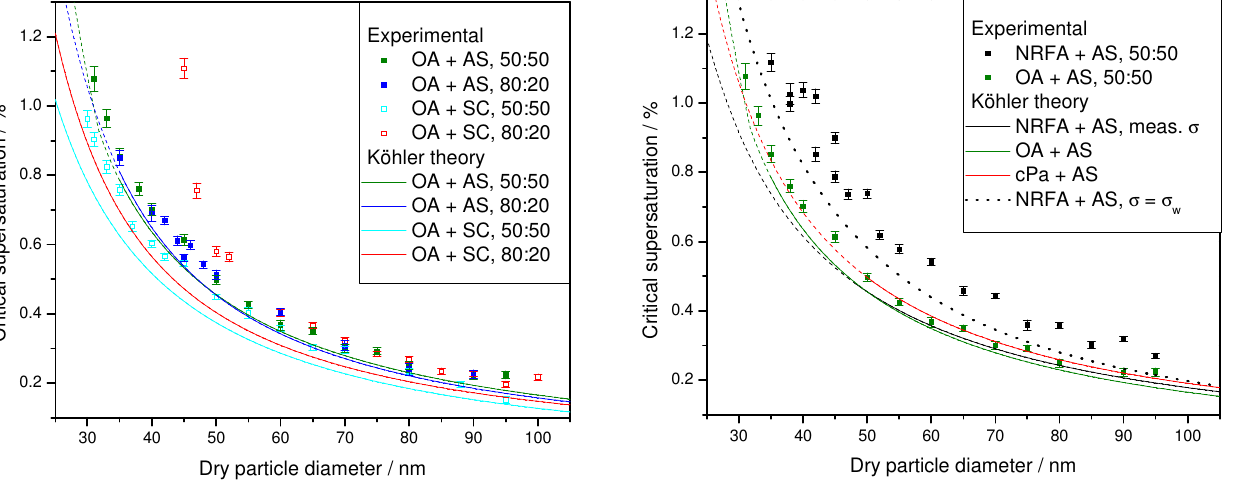
Fig. 9. Comparison between critical supersaturation measured with CCNC and calculated K¨ohler theory based on measured water ac- tivity and surface tension for mixtures containing the most surface active organic compounds (abbreviations are explained in Table 1). The dashed sections indicate that the parameterizations of water ac- tivity and surface tension are/or based on